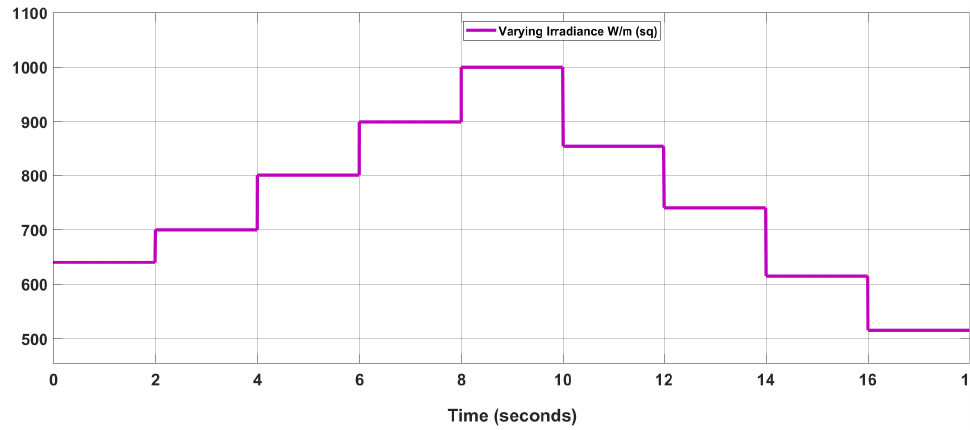
Figure 5. Varying Irradiance (W/m 2 ) of